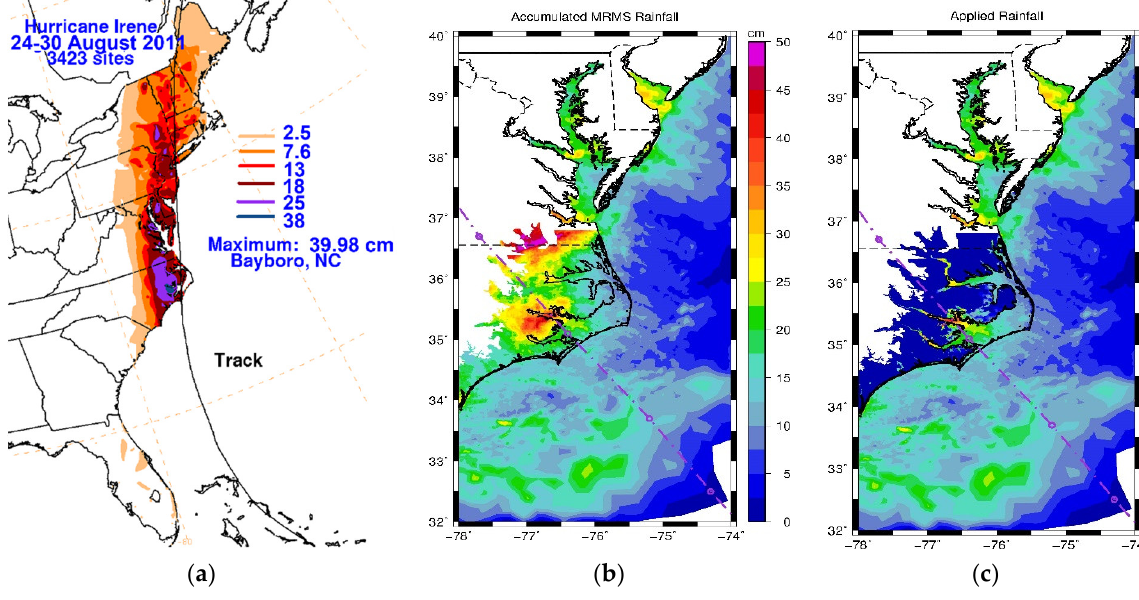
Figure 7. Accumulated rainfall (in cm) during Hurricane Irene obtained from: ( a ) NOAA [46] during 24–30 August 2011; ( b ) MRMS reanalysis data input into the ADCIRC model (at 5-min intervals) during 20–30 August 2011 and ( c ) actual rainfall amounts that were applied to wet nodes within the ADCIRC model. Solid black lines denote the coastline, but not the full water-only model domain.